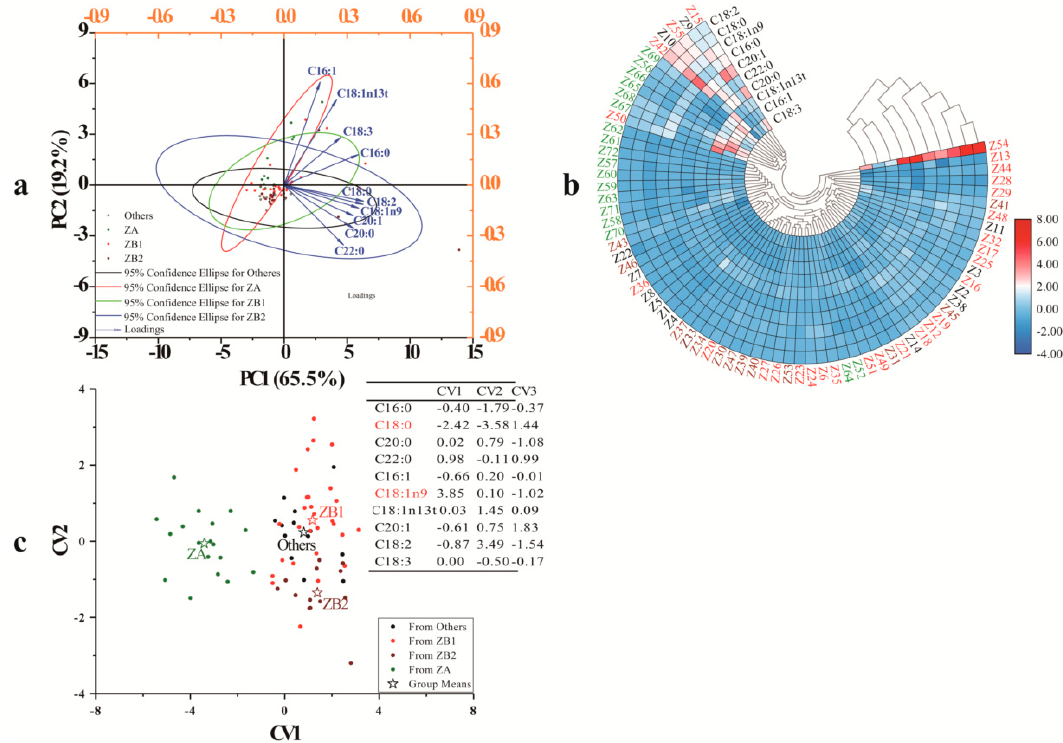
Figure 3. Geographical differentiation of Zanthoxylum pericarps from 72 plantations based on fatty acids compositions in pericarps: ( a ) principle component analysis of loading plot, ( b ) cluster heat map, ( c ) discriminant analysis. PC is principle component; CV is canonical variable; ZA is Z. armatum ; ZB1 samples, belonging to Z. bungeanum , are represented by pericarps from Hancheng; ZB2 samples, belonging to Z. bungeanum , are represented by pericarps from Fengxian; Others refers to the rest of the samples whose pericarps are red but do not belong to Z. bungeanum ; C16:0 is palmitic acid; C18:0 is stearic acid; C20:0 is eicosanoic acid; C22:0 is behenic acid; C16:1 is palmitoleic acid; C18:1n9 is oleic acid; C18:1n13t is trans-13-oleic acid; C20:1 is cis-11-eicosenoic acid; C18:2 is linoleic acid; and C18:3 is linolenic acid.